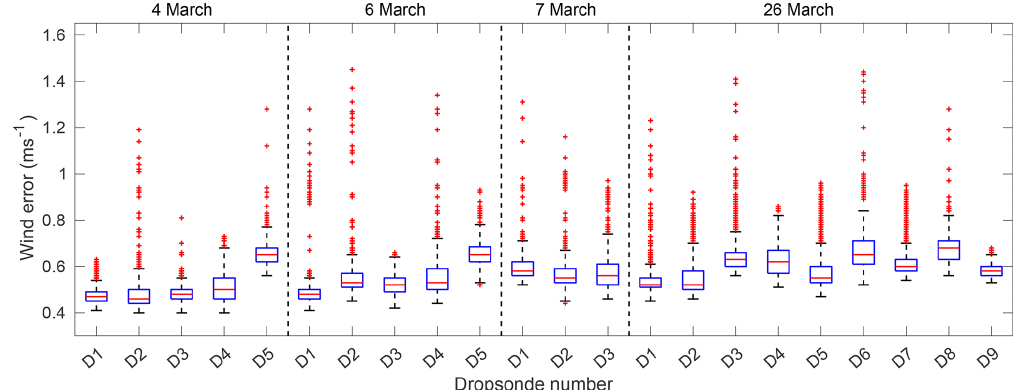
Figure 4. Distribution of the wind errors for each dropsonde listed in Table 2. Red lines show the median, the boxes are bounded by the upper and lower quartiles, the whiskers include the interval of approximately 99.7% of the values, and red crosses denote outliers.